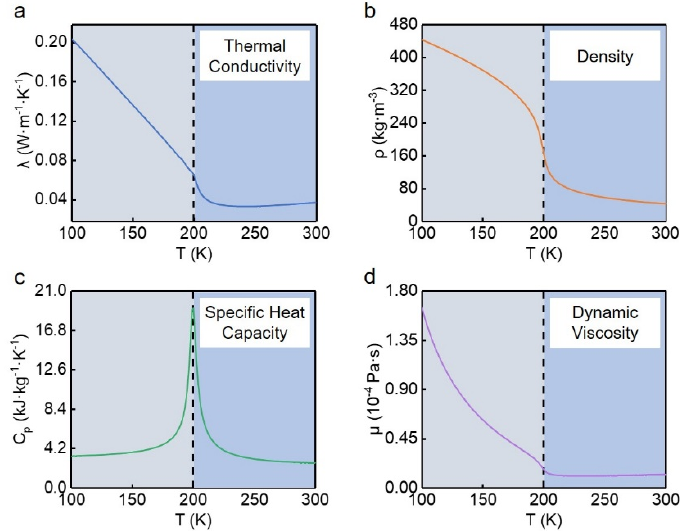
Figure 3. Variation of thermo-physical properties of methane. ( a ) Thermal conductivity; ( b ) Density; ( c ) Specific heat capacity; ( d ) Dynamic viscosity.